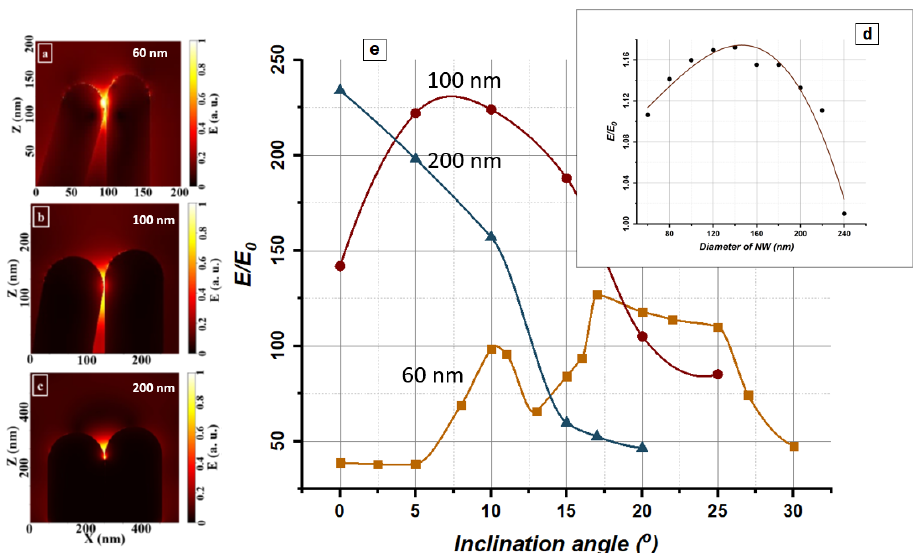
Figure 3. ( a – c ) Electric field enhancement (E/E0) in the area between leaning NW tips: ( a ) nanowire diameter of 60 nm, tilt angle of 20 degrees; ( b ) nanowire diameter of 100 nm, tilt angle of 10 degrees; ( c ) nanowire diameter of 200 nm, tilt angle of 10 degrees; ( d ) The dependence of the electric field enhancement on the nanowire diameter (excitation is under the 532 nm CW laser); ( e ) Dependence of the maximum local field enhancement (E/E0) in the area between leaning NW tips on the tilt